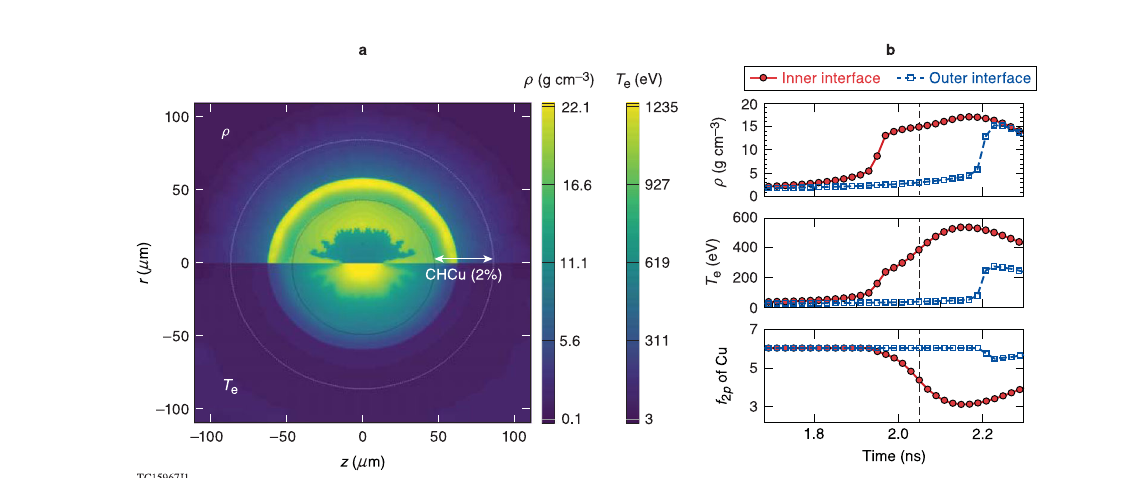
Fig. 5 | The rad-hydro-predicted warm-/hot-dense plasma conditions during core fl ash of Cu-doped CH target implosions on OMEGA. a The density (upper) and temperature (down) contour plots of dense plasma conditions at stagnation (t=2.05ns) from 2D DRACO radiation-hydrodynamic simulation. The inner and outercirclesofdottedlinesindicatetheinnerandouterboundaryoftheCu-doped